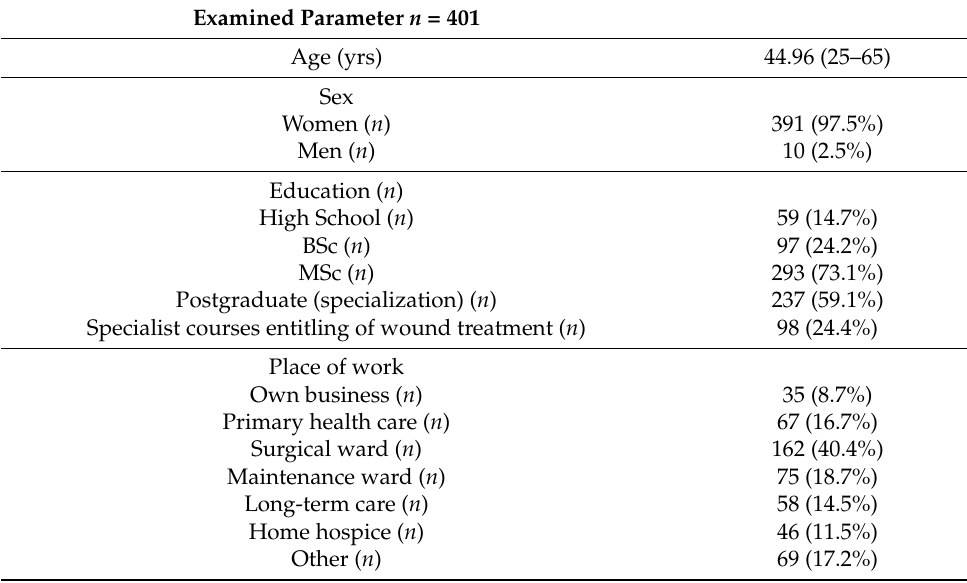
Table 3. Clinical and sociodemographic characteristics of the study participants.